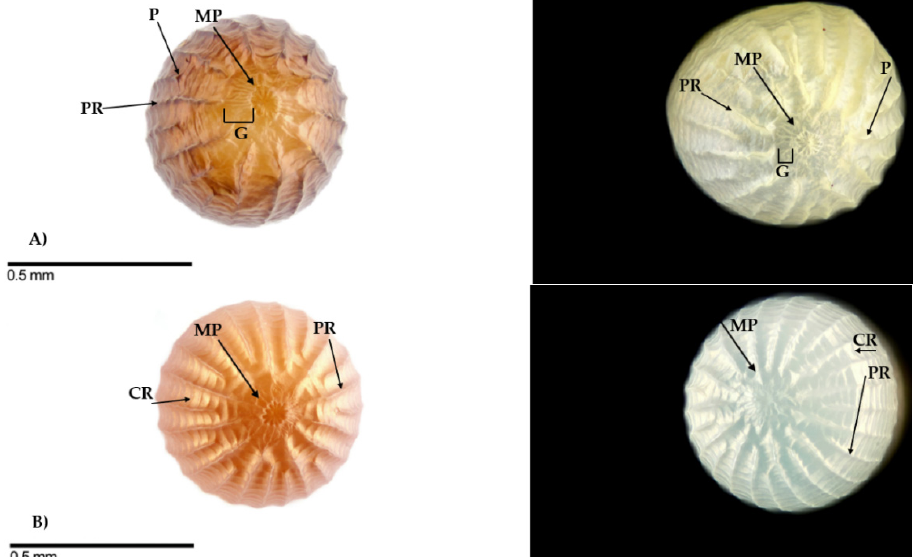
Figure 1. Diagnostic morphological features that separate C. virescens from H. zea eggs; different eggs are pictured left and right. ( A ) Chloridea virescens and ( B ) Helicoverpa zea egg photographs taken with a Canon 60D DSLR and 20× microscope lens attachment. The black arrows and letters indicate the following structures on the eggs: MP = micropyle region, PR = primary ribs, CR = cross ribs, G = gap, and P = points. Eggs were frozen for different amounts of time, which caused the difference in color and shape seen in these photographs.